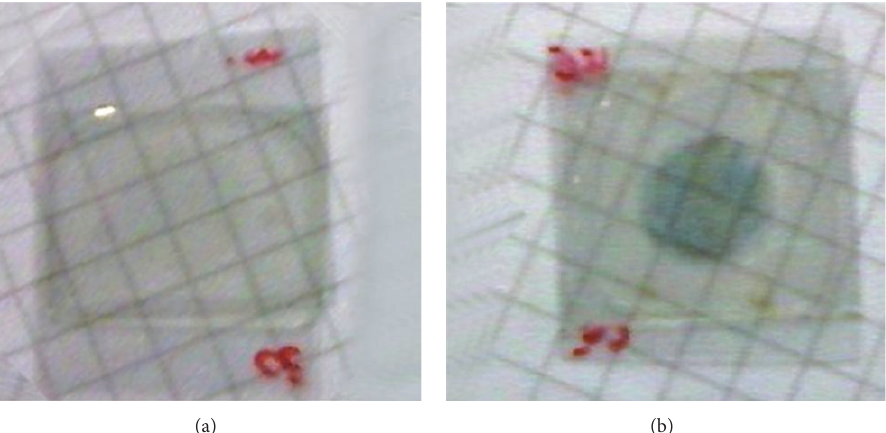
Figure 5: Single electrode EC device with BEMA/PEGMA electrolyte in bleached (a) and coloured state (b). Electrodes configuration: WO 3 /ITO/PET as cathode and ITO/PET as anode and reference